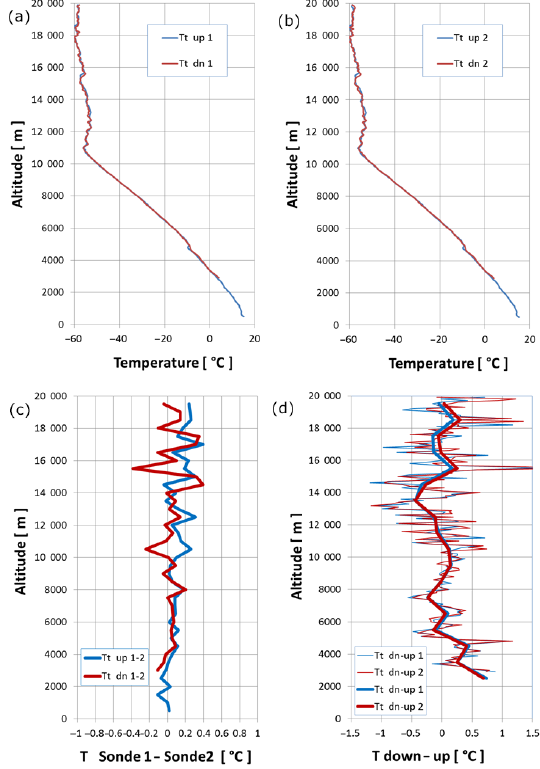
Figure 14. Temperature measurements by two SRS-C34 radioson- des during ascent to 20km and controlled descent using standard temperature sensors (Tt) mounted to the top of the radiosondes. Shown are (a) ascent and descent temperature profiles measured by sonde 1, (b) same as (a) but measured by sonde 2, (c) temperature differences between the two sondes and (d) descent–ascent temper- ature differences for each of the two sondes at vertical resolutions of 100m (thin curves) and 1000m (thick curves).